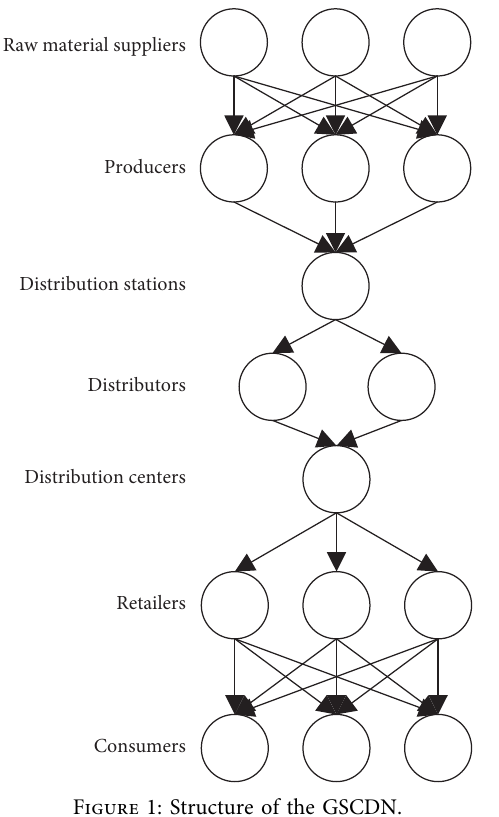
Figure 1: Structure of the GSCDN.